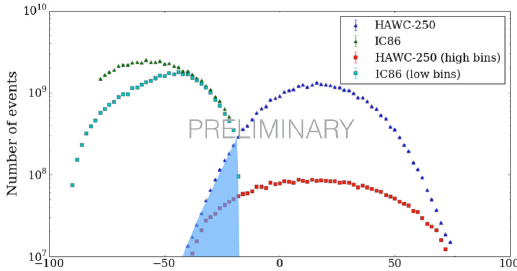
Figure 3: Distribution of events as as a function of declination for IceCube (IC) and HAWC. The shaded area corresponds to the overlapping region for both experiments